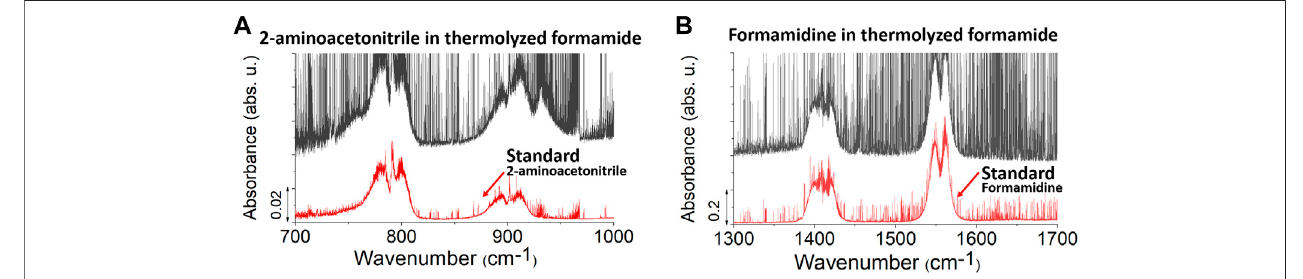
FIGURE 2 | Panel (A) Measured ] 9 and ] 8 spectral bands of gas-phase 2-aminoacetonitrile ( black trace ) following formamide thermolysis in presence of iron-rich smectite, compared with gas-phase spectra of neat 2-aminoacetonitrile ( red trace ). Panel (B) The ] 6 and ] 5 bands of formamidine following thermolysis for formamide and in a standard